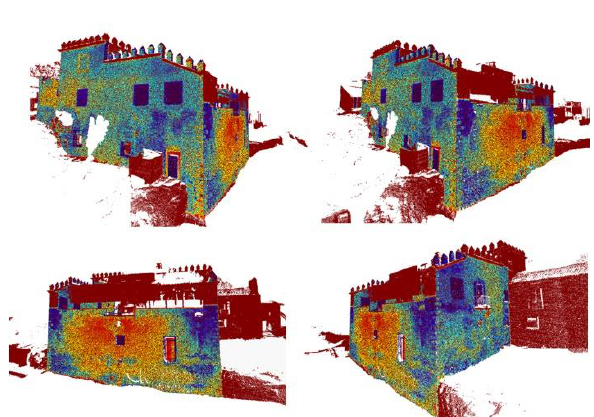
Figure 5. Deformation pattern of the